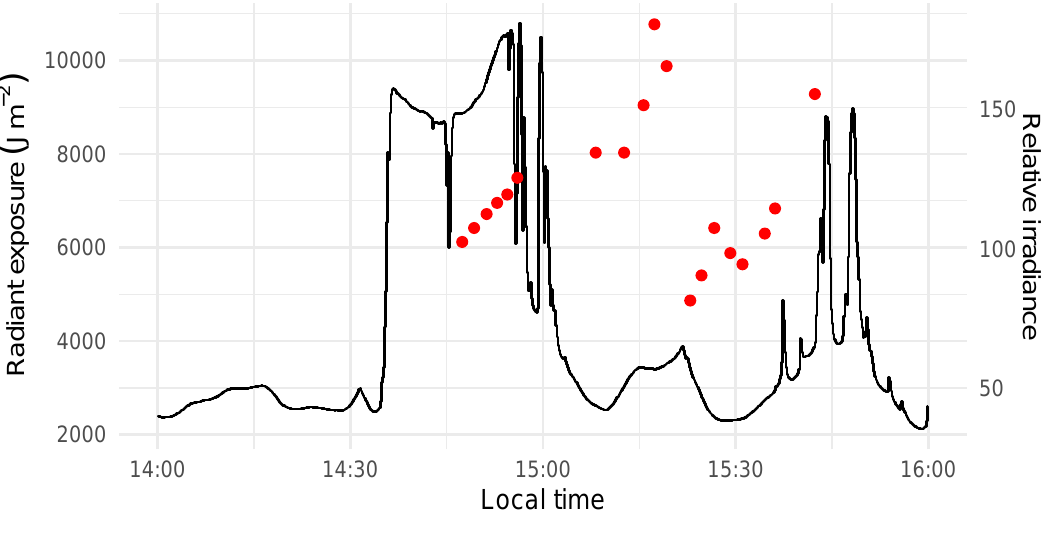
Figure 2. Radiometric measurements of ambient illumination during the acquisition of the hyperspectral imagery. The black line represents radiant exposure values integrated over 10-s intervals. The red dots represent readings from a relative irradiance sensor associated with the individual images. The hyperspectral data cubes comprised 41 evenly spaced bands ranging from 503 to 903 nm. The spatial resolution was 1010 × 1010 pixels and the radiometric resolution was 12 bits. The integration time was set to 30 ms. The pot rims were approximately 0.70 m away from the camera lens, resulting in a GSD of approximately 0.43 mm per image